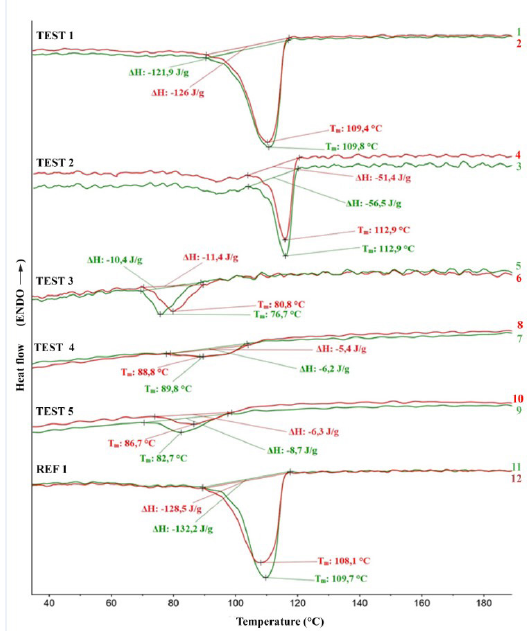
Figure 7. DSC cooling thermograms of TEST 1 (curves 1 and 2), TEST 2 (curves 3 and 4), TEST 3 (curves 5 and 6), TEST 4 (curves 7 and 8), TEST 5 (curves 9 and 10) and REF 1 (curves 11 and 12) samples after the biodegradation soil test (red curves) compared to the initial samples (green